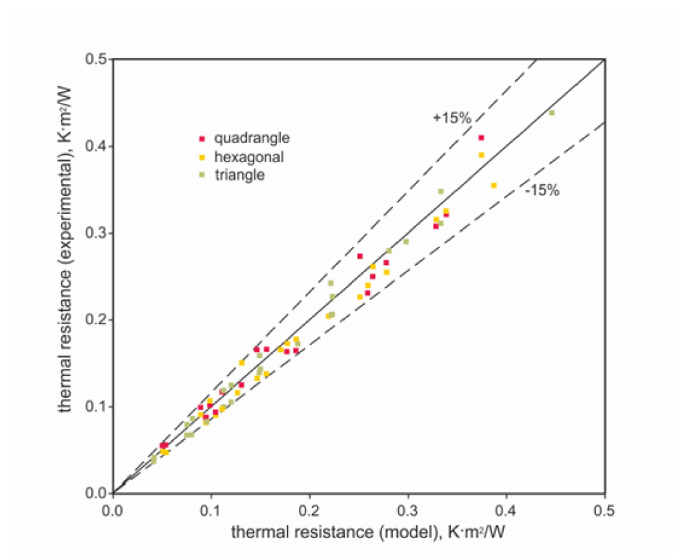
Figure 8. Comparison of the thermal resistance of insulation that was obtained from the calculations and experimental measurements.